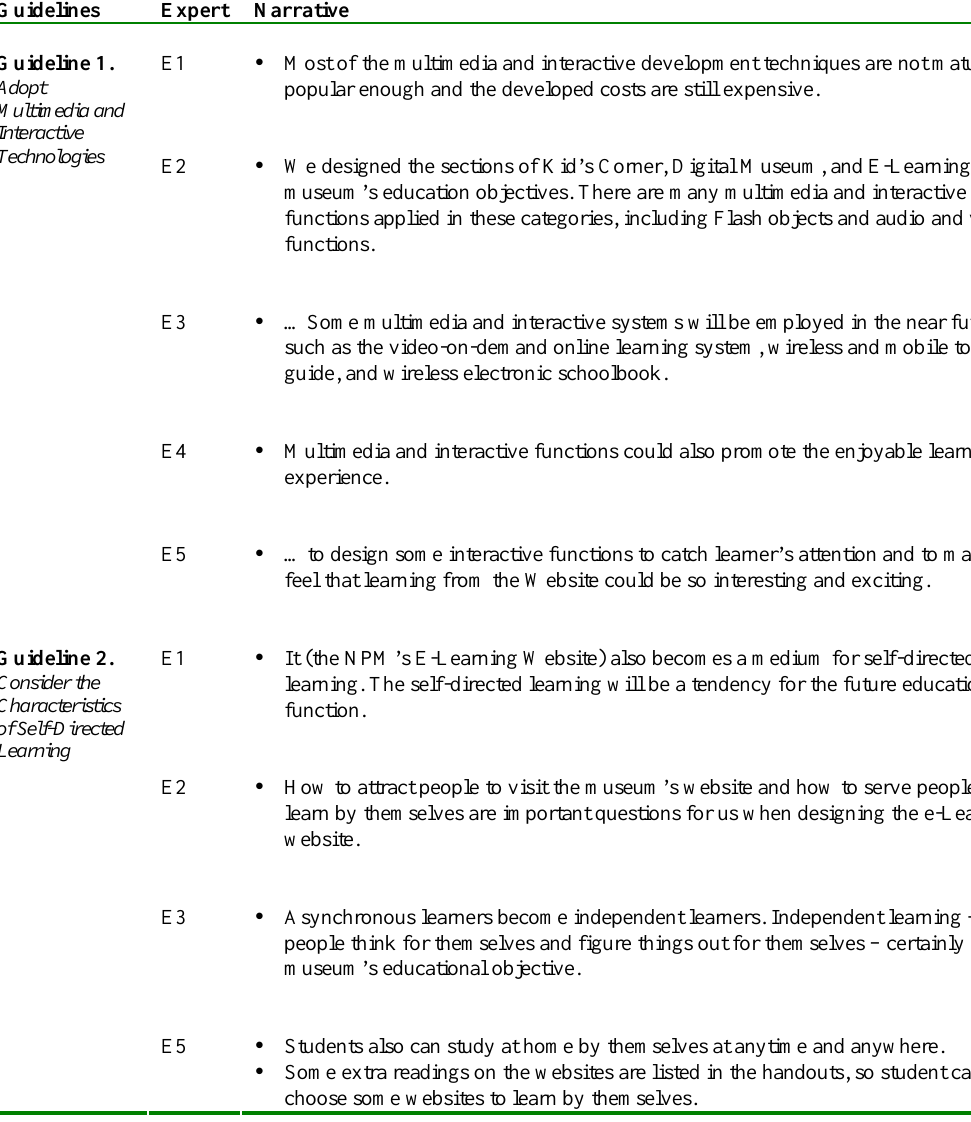
Table 3: Illustrative narrative extracts for the design of an e-Learning website for